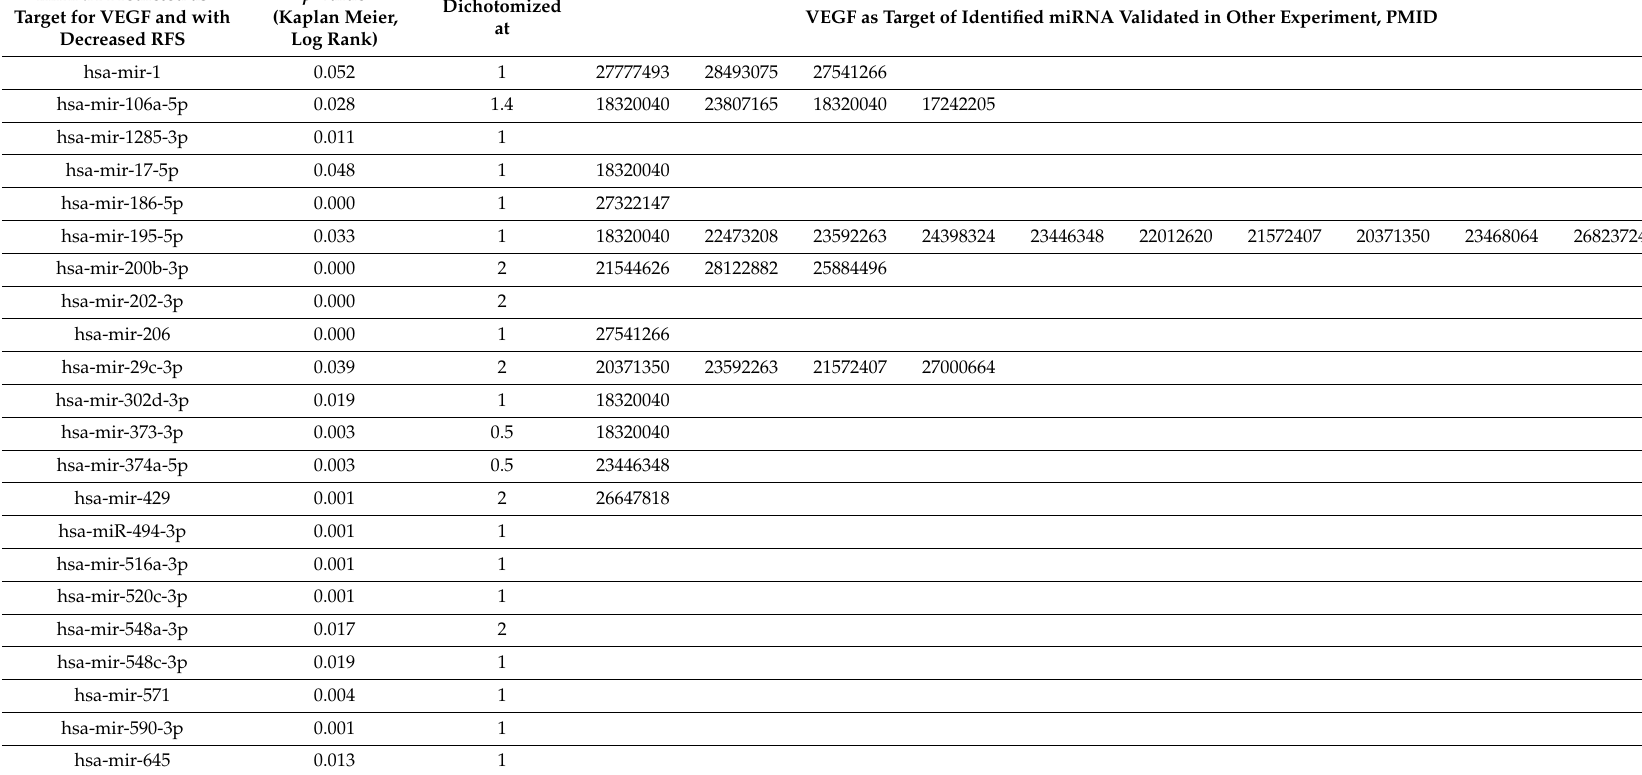
Table 2. MiRNA predicted as target for vascular endothelial growth factor (VEGF) and with decreased RFS and PubMed Identifier (PMID) of miRNA–VEGF interaction validated in other